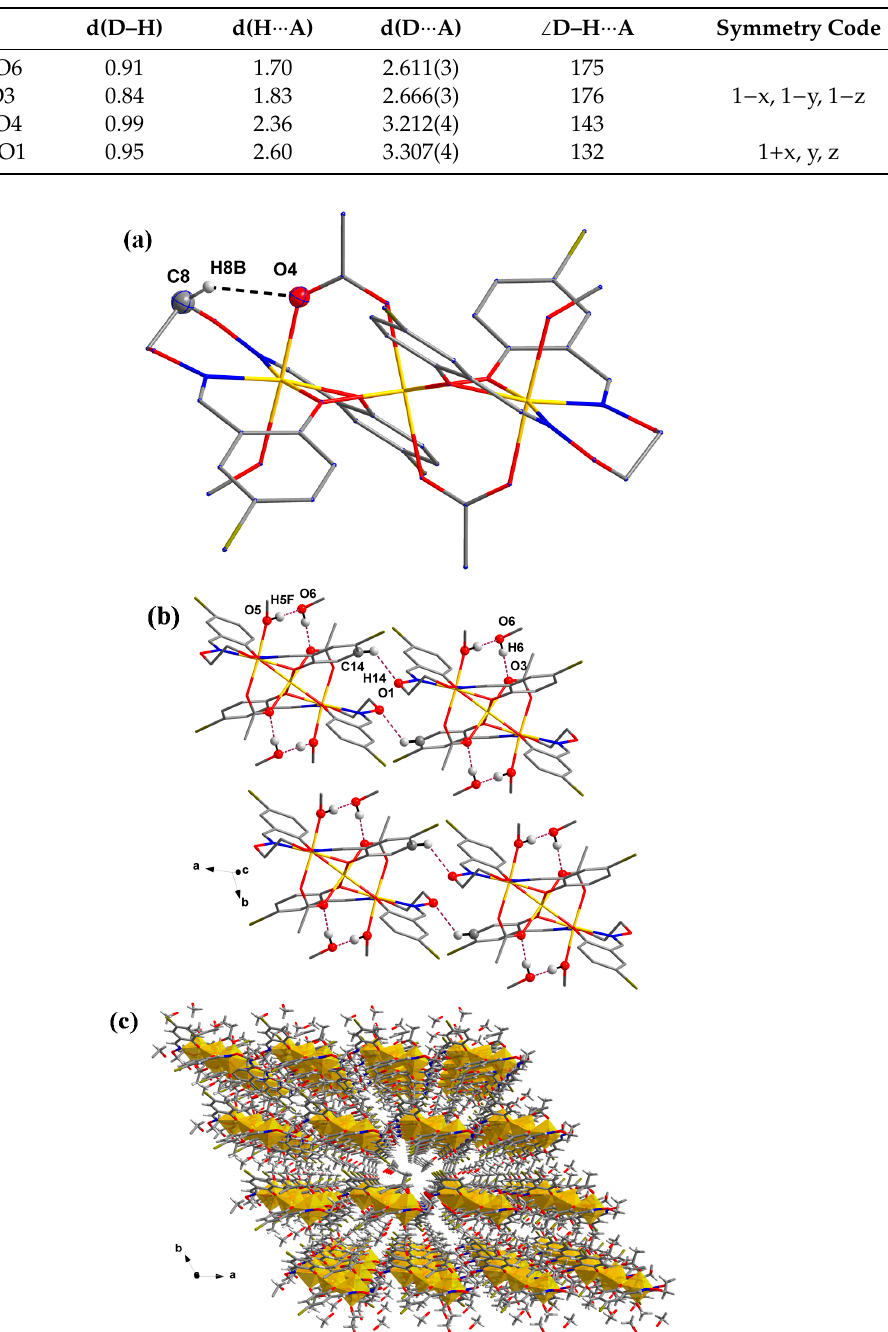
Figure 5. View of the hydrogen bonding interactions of the Co(II) complex (hydrogen atoms are omitted for clarity, except those forming hydrogen bondings): ( a ) Intra-molecular hydrogen bonding interaction; ( b ) Inter-molecular hydrogen bonding interactions; ( c ) 3-D supra-molecular structure. Table 3. Hydrogen bonding interactions (Å, °) of the Co(II) complex.